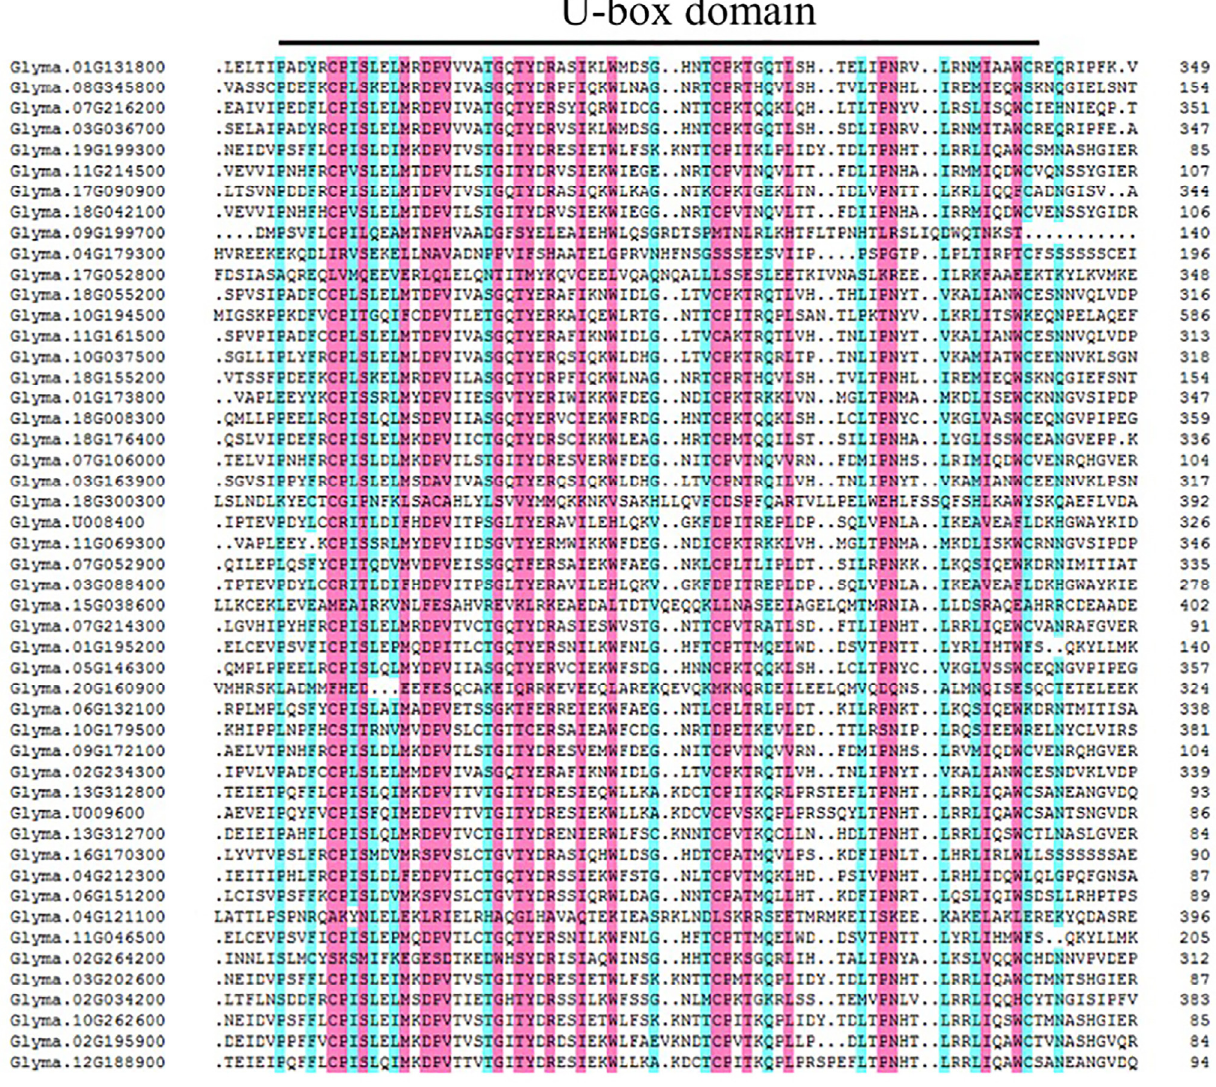
Figure 1. Multiple alignment of amino acid sequences of 49 GmPUBs proteins. Note: pink and blue indicate 75% and 50% homology of amino acids, respectively. The number on the right of each amino acid sequence represents the relative position of the last residue. The U-box domain is marked at the top of the alignment with black solid lines.